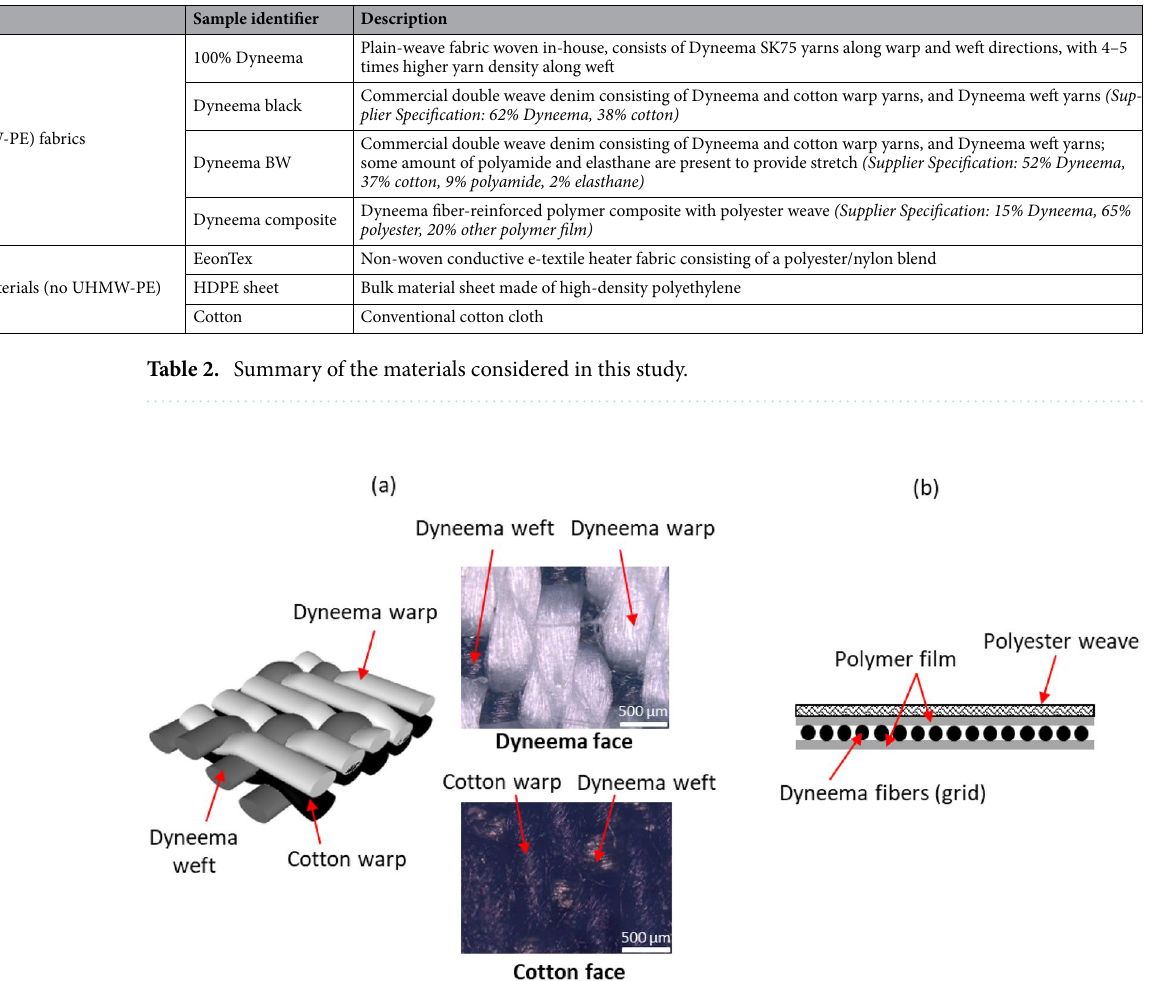
Figure 2. Representative schematics of the commercial Dyneema fabric samples: ( a ) the Dyneema denim fabric weave structure consisting of Dyneema and cotton yarns, with optical micrographs of the Dyneema and cotton faces for the Dyneema Black fabric shown as an example. ( b ) The Composite Dyneema fabric sample consisting of a grid of Dyneema fibers sandwiched between polymer films, with a polyester weave attached on one